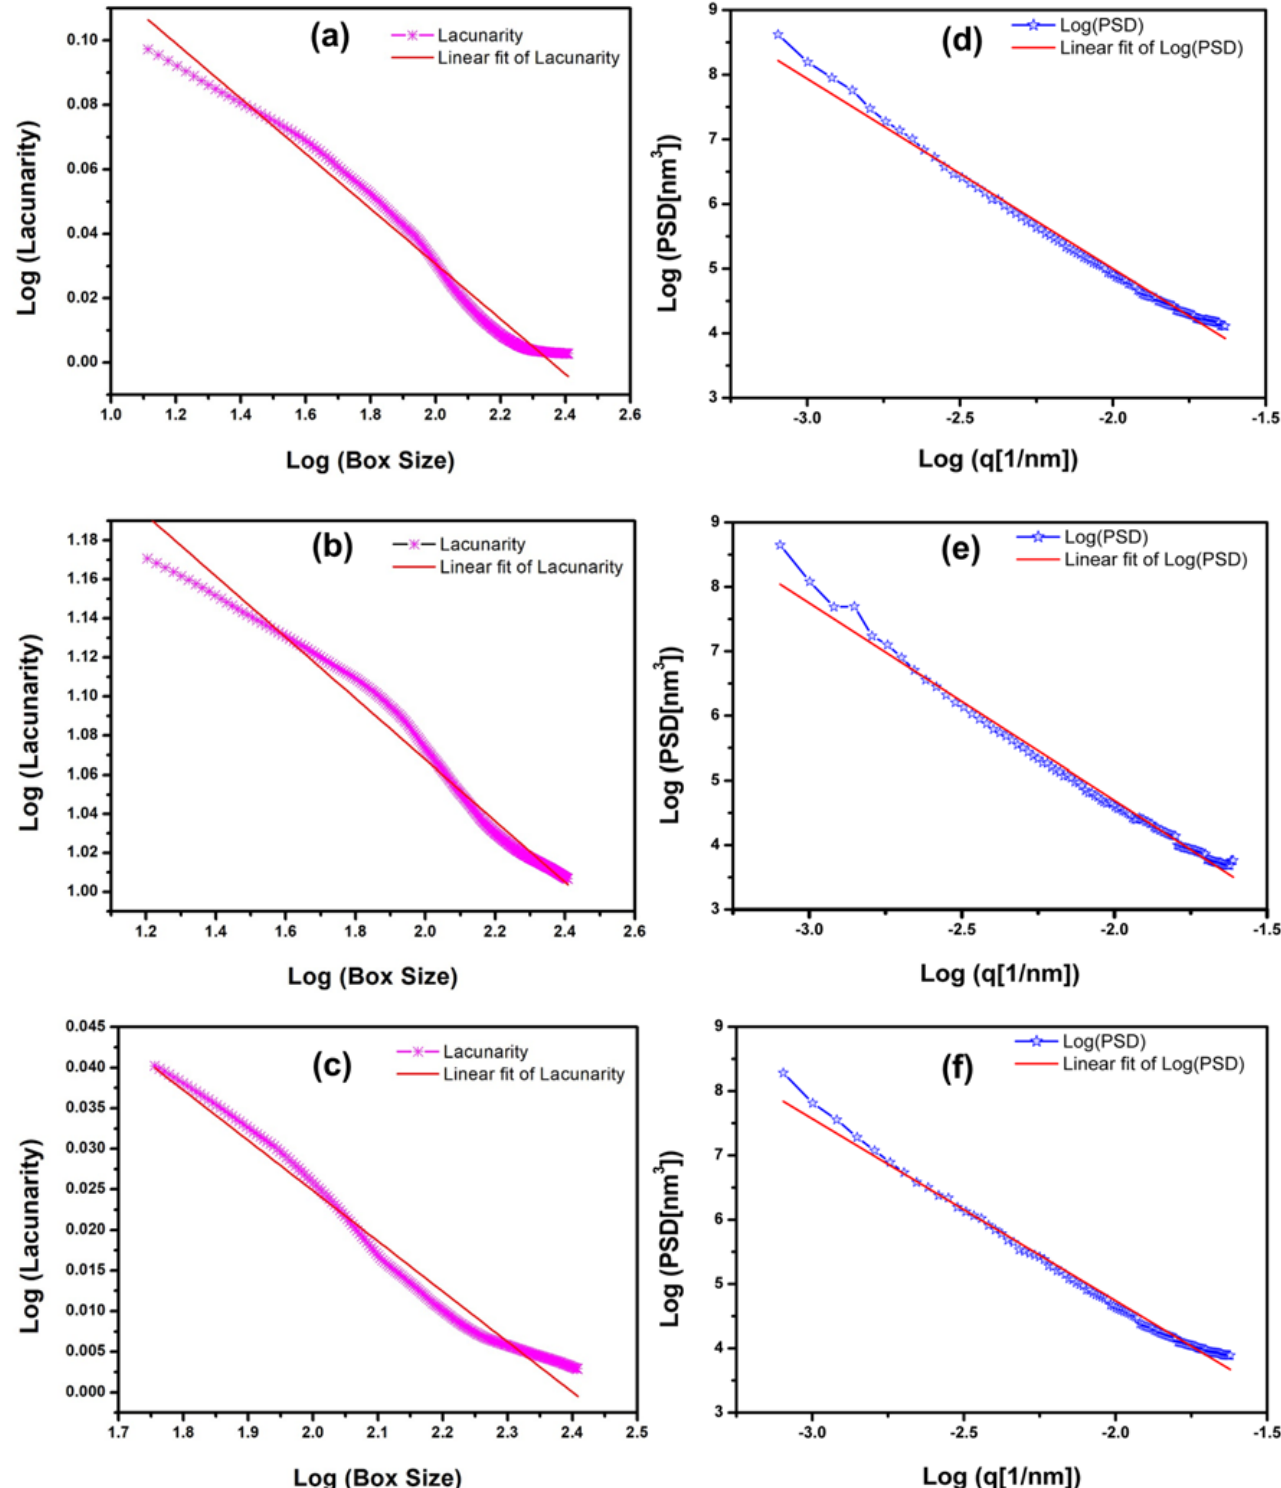
Figure 5. Log–log plots of ( a – c ) lacunarity versus box size and ( d – f ) PSD versus q , including linear regressions that allowed us to estimate the lacunarity coefficient ( |β| ) and the Hurst coefficient ( H ) of ( a – d ) untreated, ( b – e ) HDMSO-treated, and ( c – f ) He/HDMSO-treated TPS films.